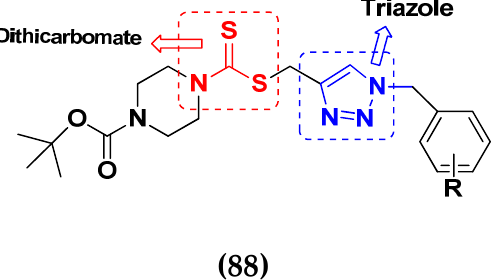
Figure 85. Structure of triazole-dithiocarbamate derivatives ( 88 ).